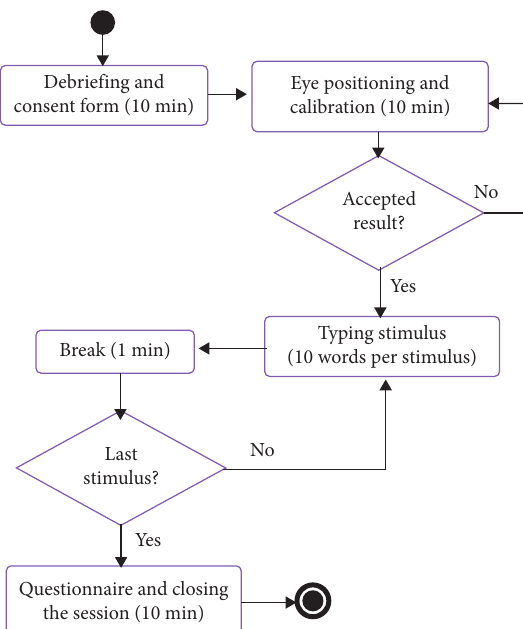
Figure 7: Procedure followed in each evaluation